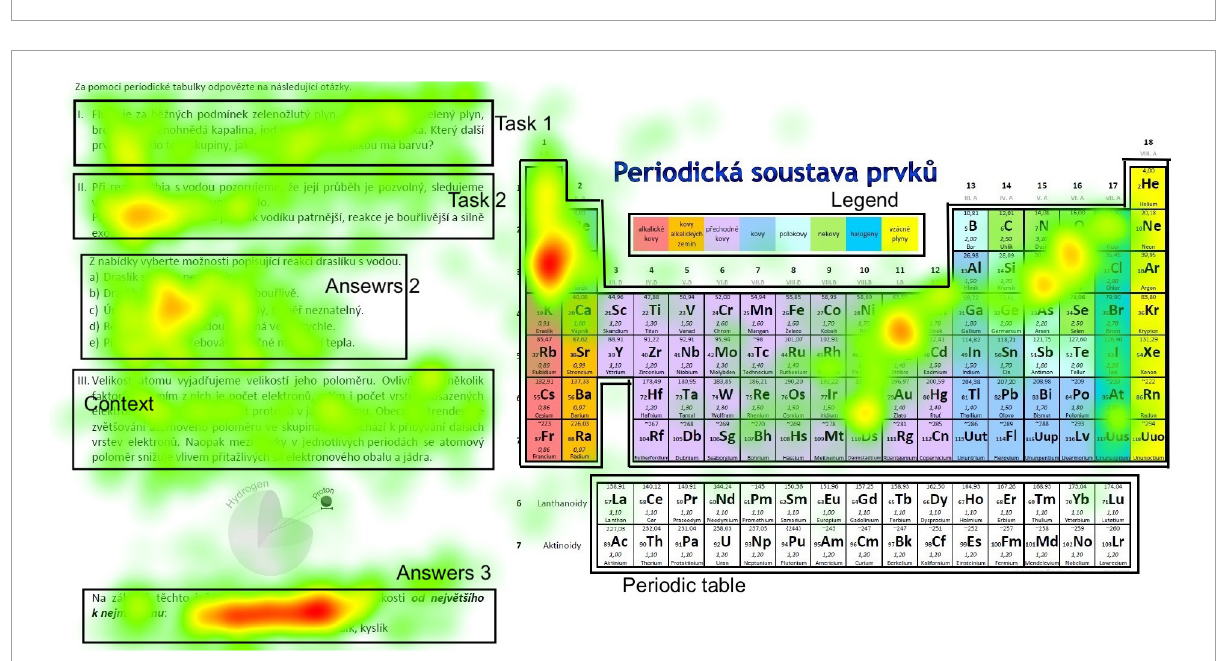
FIGURE3 Experts’ focus in the program of international student assessment (PISA) task.